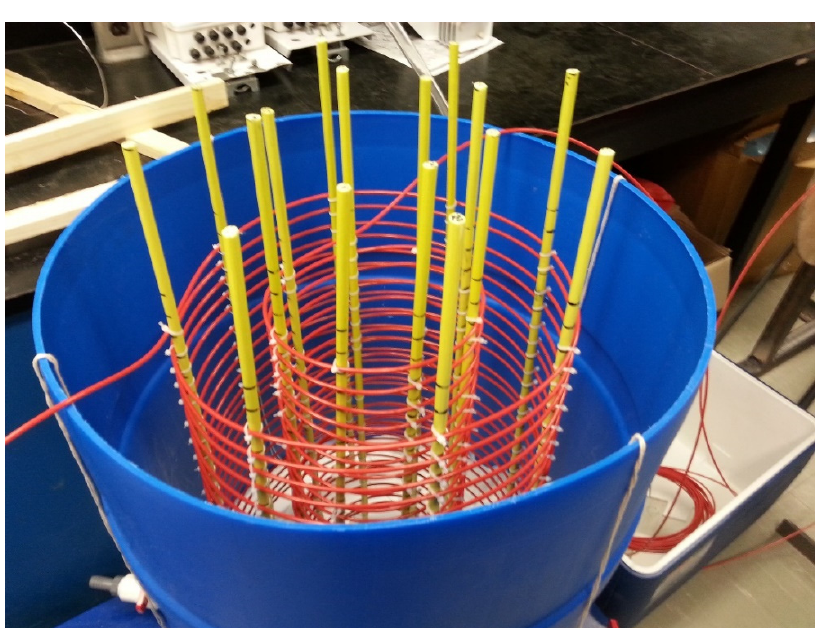
Figure 1 . The column structure developed using a plastic barrel, inner and outer cable helices, and fiber glass rods supporting the cable helices. Table 1. Sand, silt, clay percentages, and bulk densities of three soils used in the